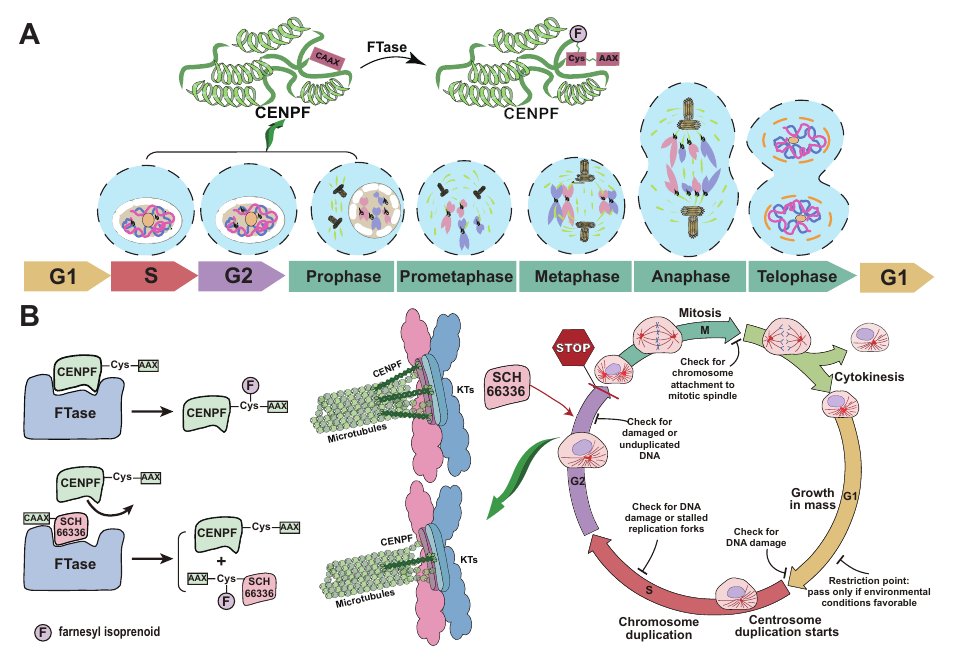
Figure 9. Farnesylation of CENPF affects cell cycle progression. ( A ) Localization of CENPF at different phases of cell cycle. Farnesylation of CENPF occurs from S phase to prophase of mitosis, involving connection of farnesyl isoprene-like compounds to the cysteine thiol group of CAAX peptide motif, catalyzed by farnesyltransferase (FTase). ( B ) SCH66336 (lonafarnib) competitively inhibits the binding of FTase to CAAX peptide of CENPF, thereby repressing its farnesylation. This competitive inhibition leads to a significant reduction of active CENPF in nucleus at prophase of mitosis and early centromere. As a result, G2/M transition is delayed due to the dysfunction of CENPF, thus cell cycle progression is restrained. F: farnesyl isoprenoid; FTase: farnesyl transferase; KTs: kinetochores; CAAX: CAAX box peptide (C: cysteine; A: an aliphatic amino acid; X: methionine, threonine, serine or glutamine); SCH66336: also known as Lonafarnib, a FTase